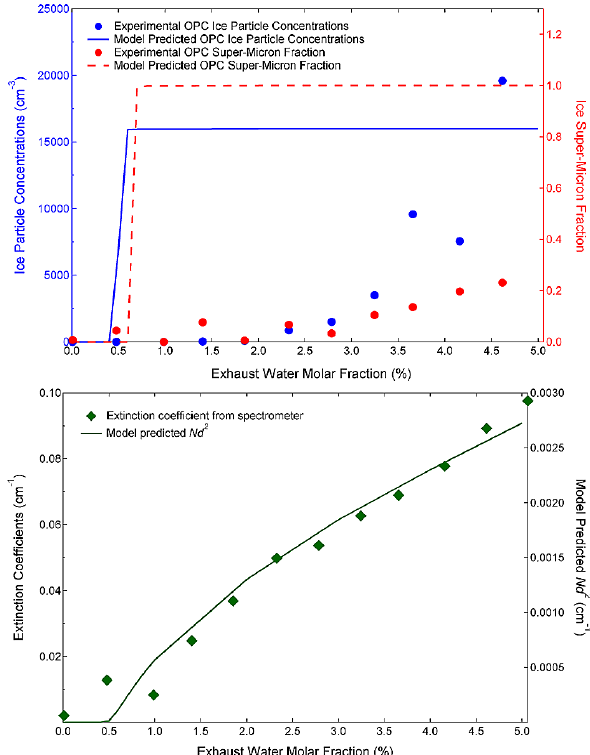
Fig. 4. Comparison of experimental and modeling results as a func- tion of exhaust water molar fraction at 61cm downstream of the exhaust nozzle: (a) model predicted and OPC measured ice particle concentration and ice particle super-micron fraction; (b) measured particle optical extinction and predicted ice particle concentration ( N ) multiplied by particle diameter squared ( d 2